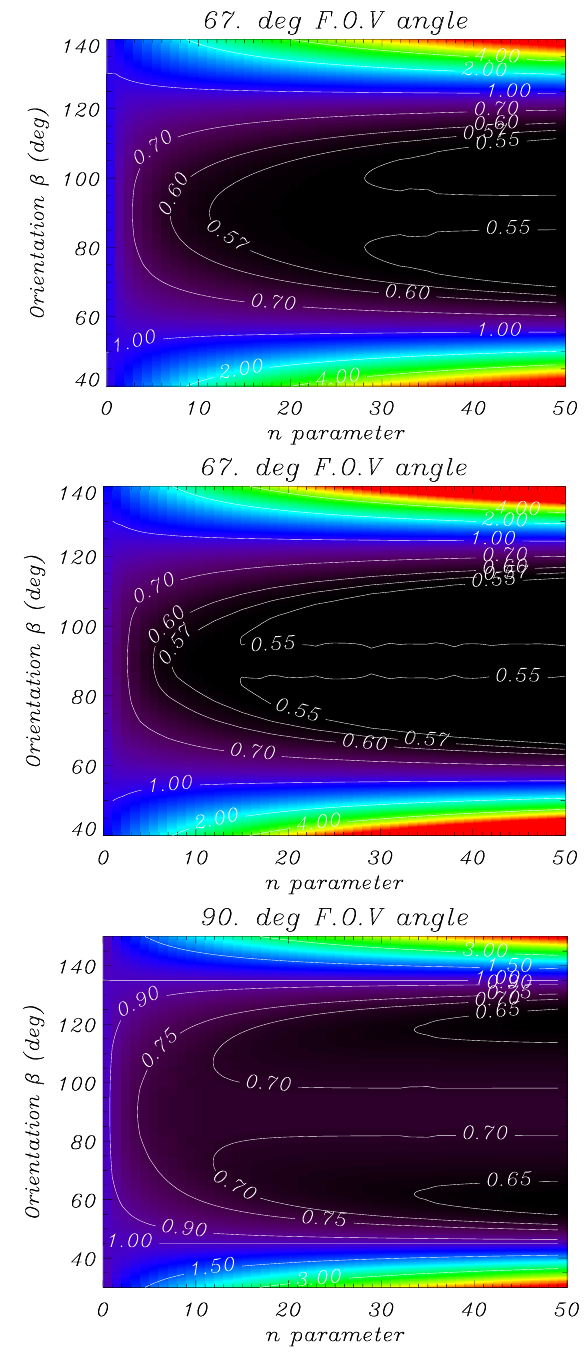
Fig. 5. Function g( β , n ) for: (a) a 1θ g 33.5deg. F.O.V. half-angle detector like the CPD with a sin n (α) pitch angle distribution; (b) a 1θ g 33.5deg. F.O.V. half-angle detector with a steep pitch angle distribution; and (c) a 1θ =45deg. F.O.V. half-angle